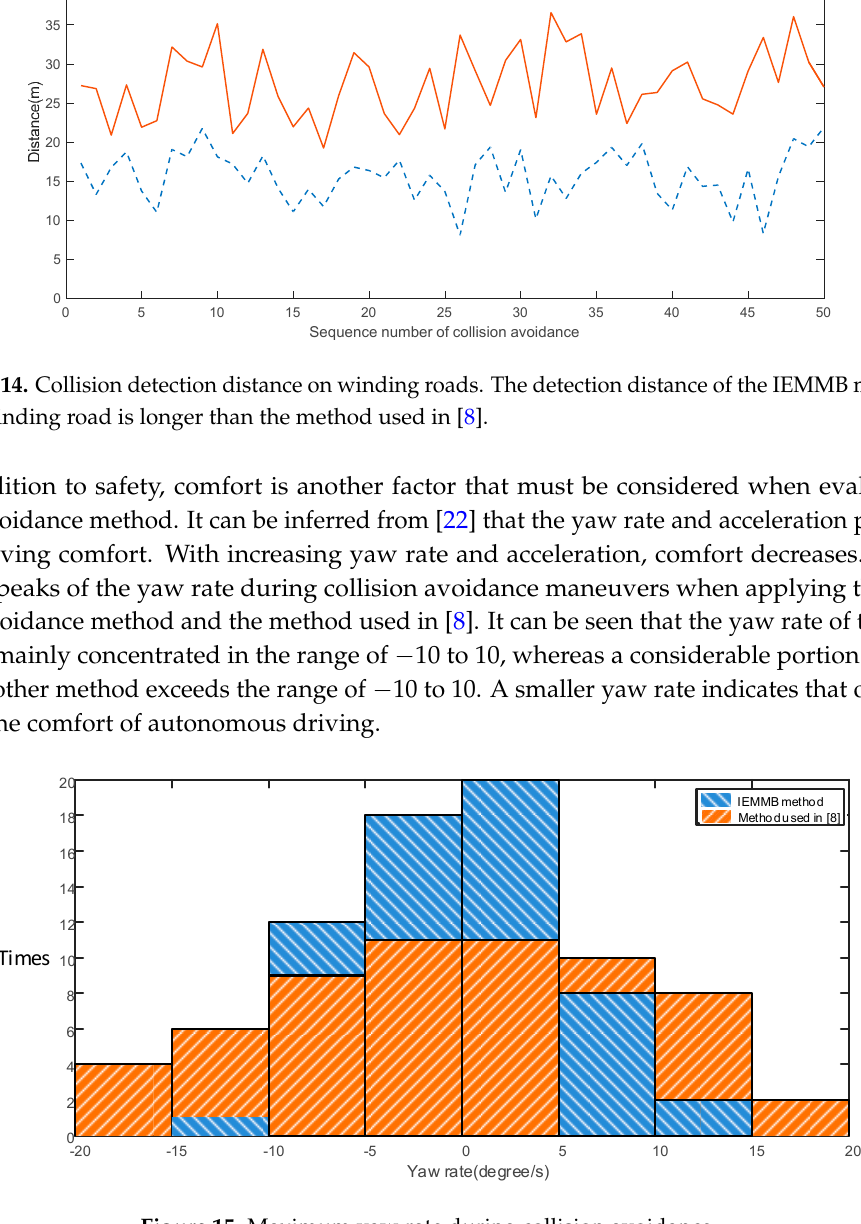
Figure 16. Maximum acceleration during collision avoidance. 3.3. Typical Collision Avoidance Scenes A typical collision avoidance scene on a straight road is shown in Figure 17. The first row shows the real scene, and the second row shows the path planning result of the autonomous vehicle during the collision avoidance. As shown in Figure 17a, the autonomous vehicle is keeping its lane, and three vehicles are detected. The left top vehicle is performing a left lane change, and two vehicles are moving along their lanes. In Figure 17b, a new vehicle is detected, which is taking a right lane change. The trajectory of the white car is predicted with the intent-estimation- and motion-model-based method, and a potential collision between the vehicle and the autonomous vehicle is detected, which is marked with a red circle. Then, a deceleration is executed, and a right lane change path is generated to avoid the collision.